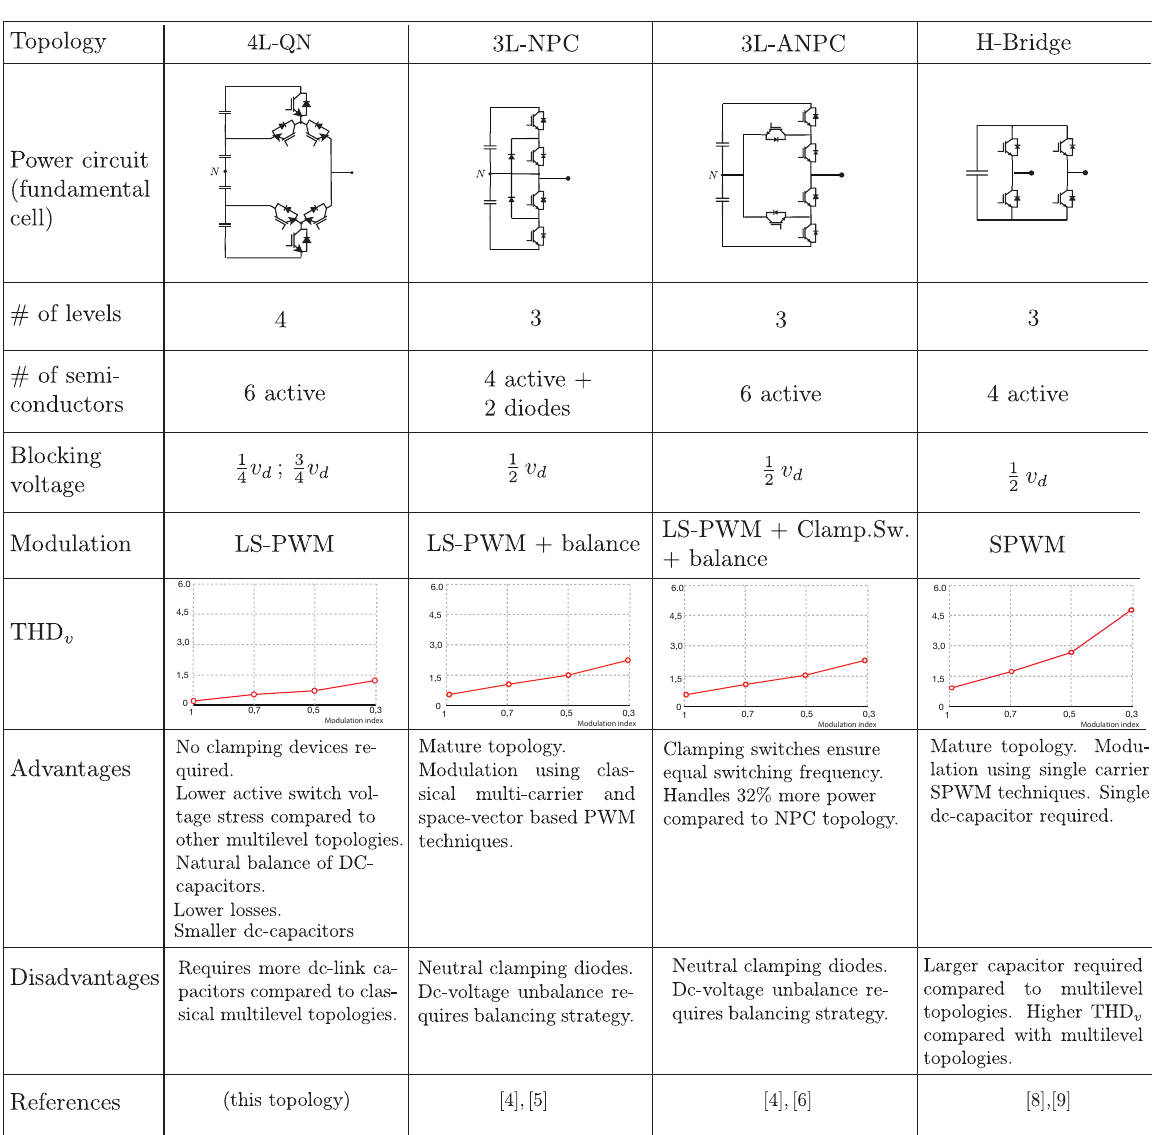
Figure 14. Comparison of the proposed topology and conventional single-phase multilevel converters. Figure 15 shows the output voltage spectrum of the proposed 4L-QN inverter operat- ing with LS-PWM and a modulation index m = 0.8, and a comparison with the voltage spectrum of H-Bridge, NPC and ANPC inverters. All the inverter topologies generate a voltage spectrum with low harmonic content at low frequencies, and the characteristic PWM switching harmonics distribution around a switching frequency of 5 kHz. The pro- posed 4L-QN inverter yields the lowest THD v among the evaluated topologies, with 65% less than H-Bridge and 32.69% less than NPC and